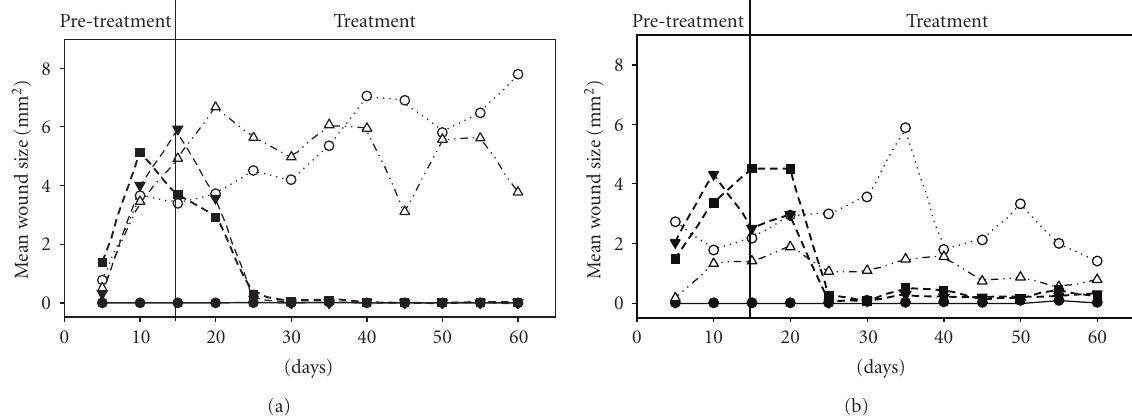
Figure 3: Mean ( n = 5) wound size for male (a) and female (b) hamsters during the experiment. Legend as in Figure